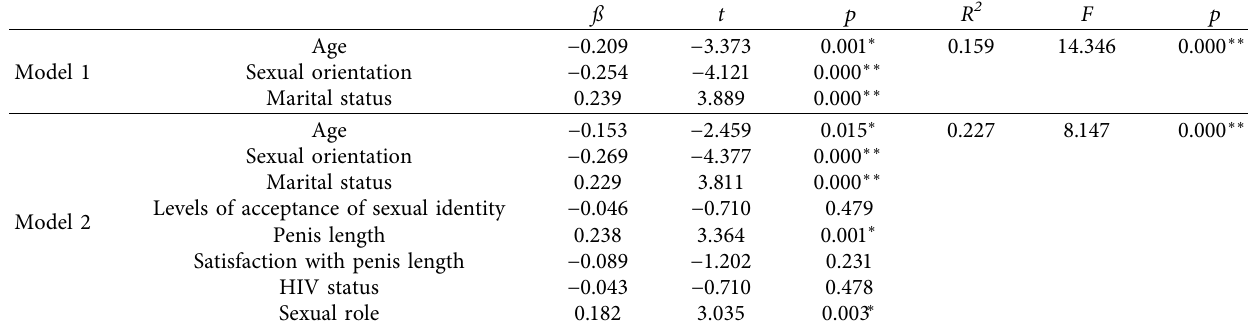
Table 3: Hierarchical multiple regression analysis predicting anal receptive sex without